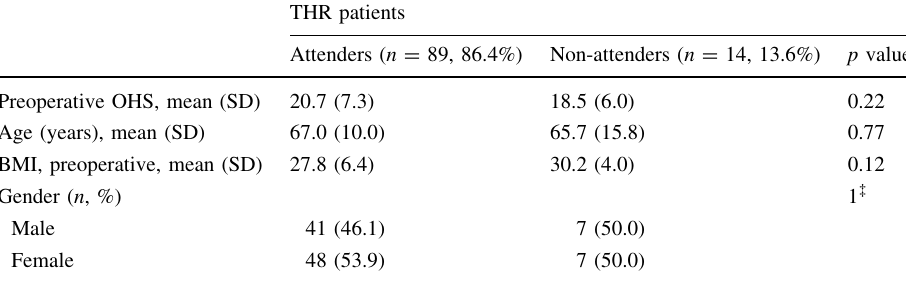
Table 1 Comparison of preoperative OHS, age, BMI and gender of attenders and